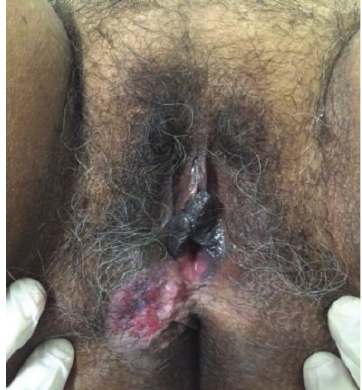
Figure 1: Photograph of the lesion prior to surgery.